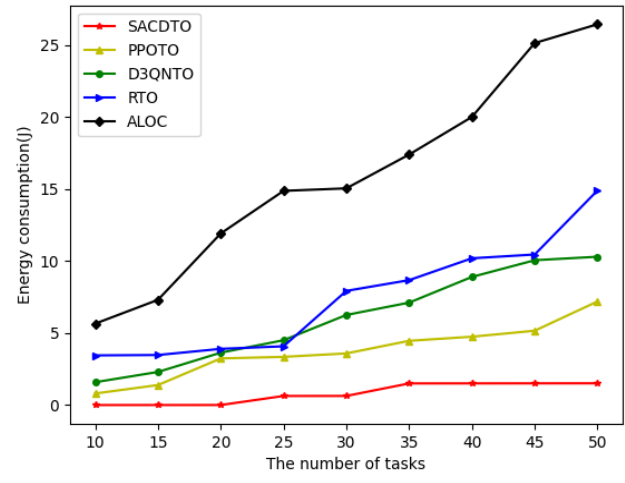
Figure 5. The Effect of Number of Tasks on Energy Consumption.